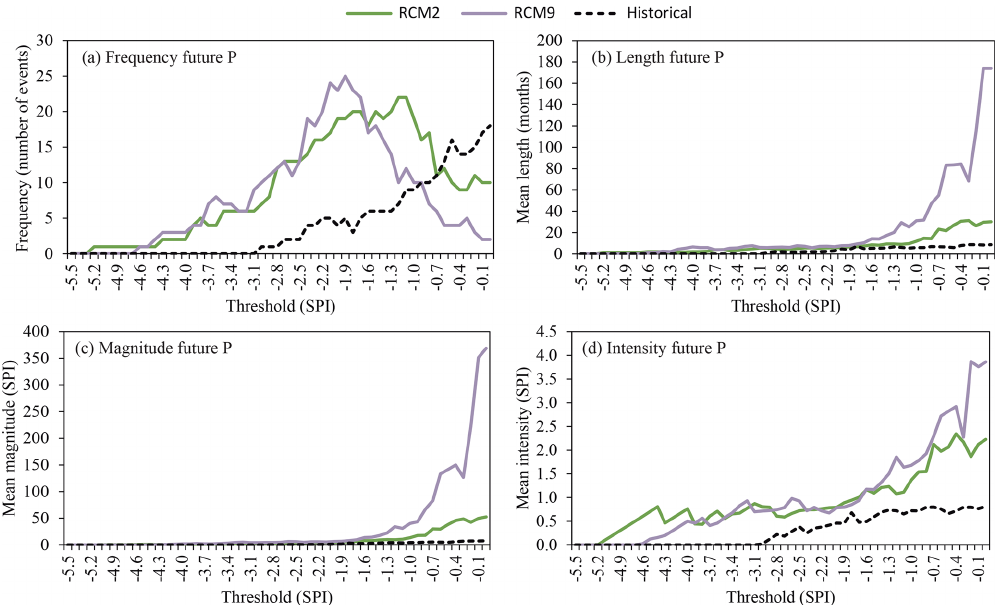
Figure 12. Drought statistics – (a) frequency, (b) length, (c) magnitude, (d) intensity – of the historical period (1972–2002) and future horizon (2071–2100) series (RCM2 and RCM9) for precipitation (meteorological